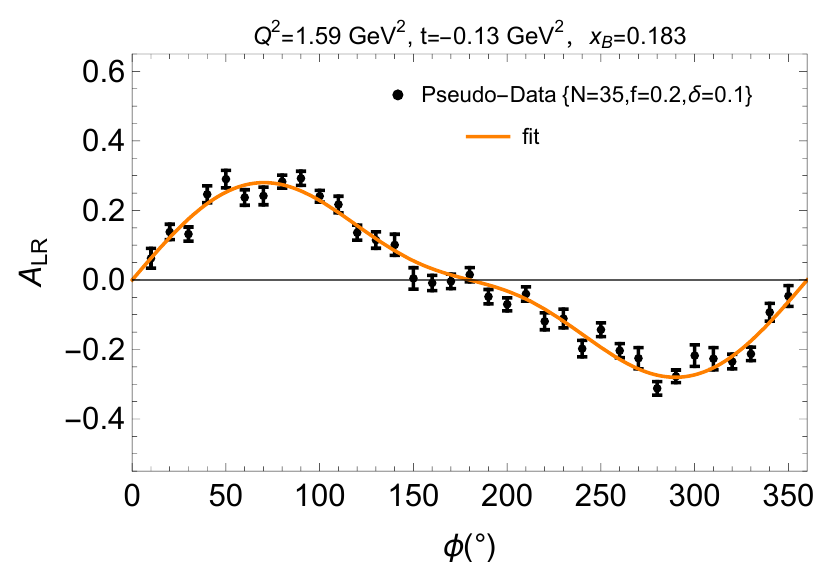
Figure 6. The result of fitting eq. (4.6) to the pseudo-data generated by eq. (4.7) with N = 35 , f = 0 . 2 and δ = 0 . 1 .